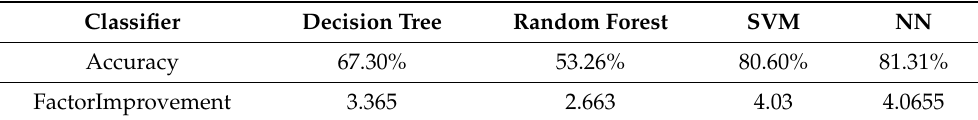
Table 1. Performance of different algorithms at classifying cell-layer (5 classes, 20% equivalent random guessing accuracy).